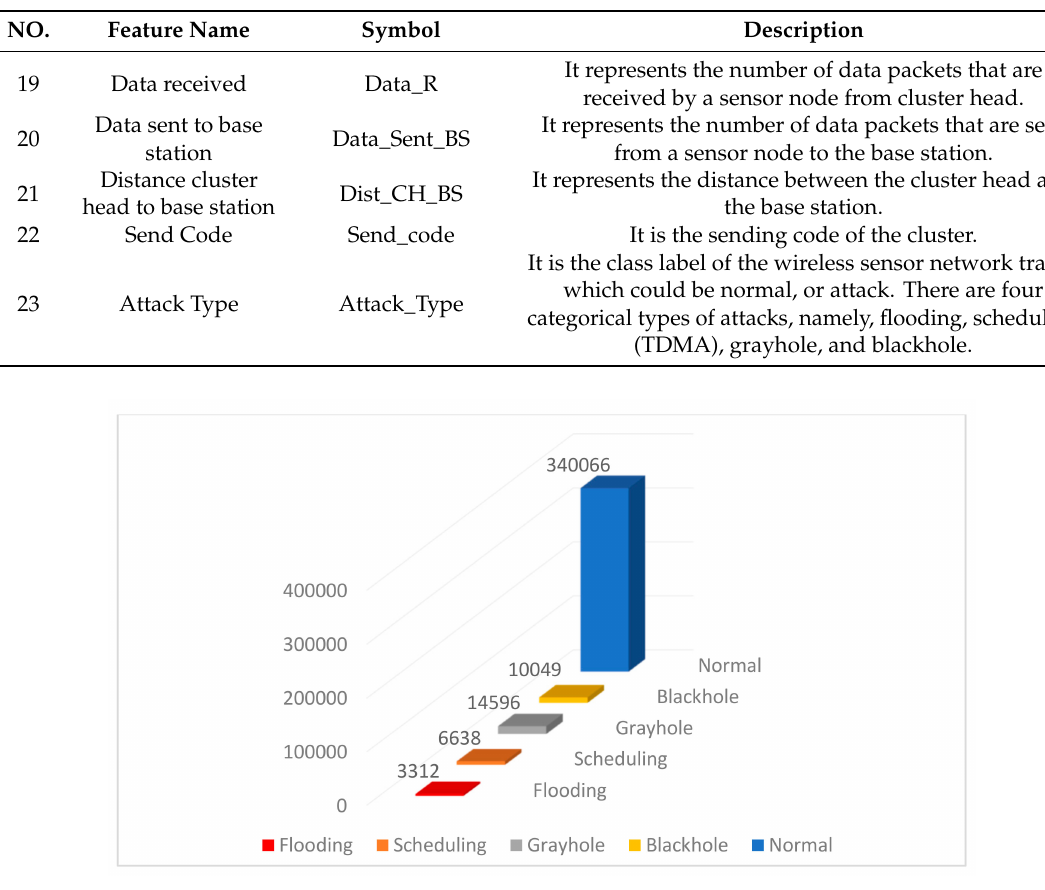
Figure 2. Distribution of attacks in the WSN-DS